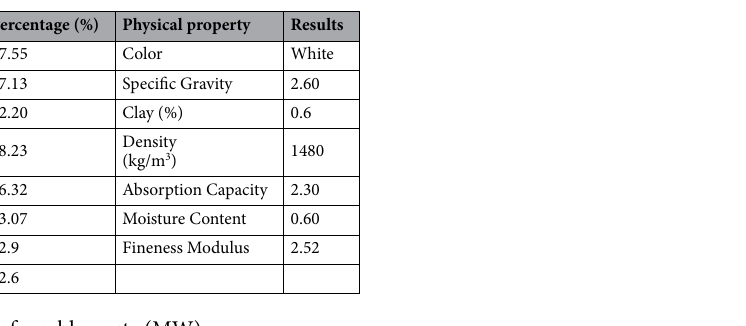
Table 4. Properties of marble waste